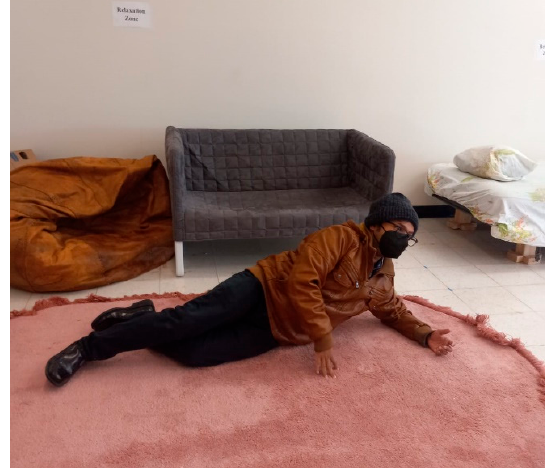
Figure 13. A participant falling in the relaxation zone. Here, a sideways fall is demonstrated.